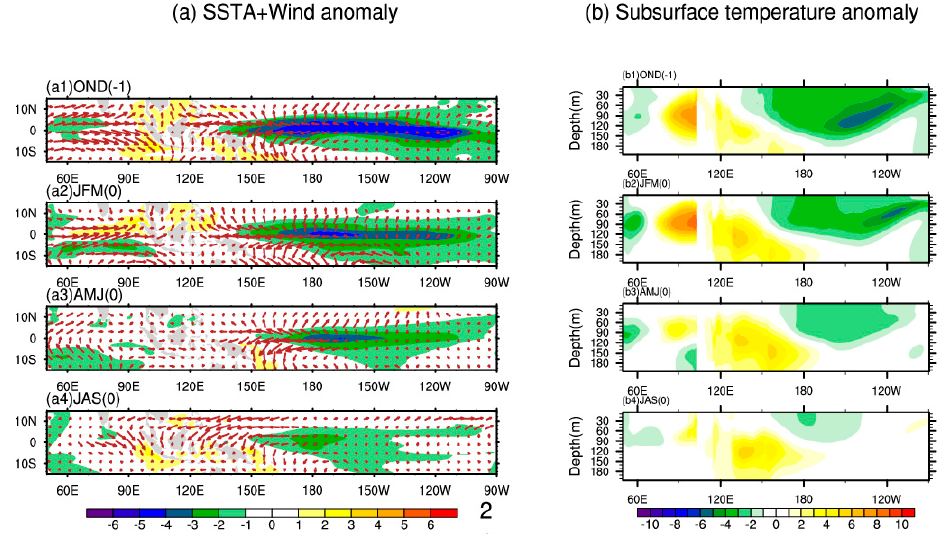
Figure 4. Composite evolutions of ( a ) tropical SST errors (units: °C) and related surface wind anomalies (units: m/s), and ( b ) the equatorial subsurface temperature errors (units: °C; averaged over 5° S by 5° N) induced by the type-1 initial errors with start month being October (-1).